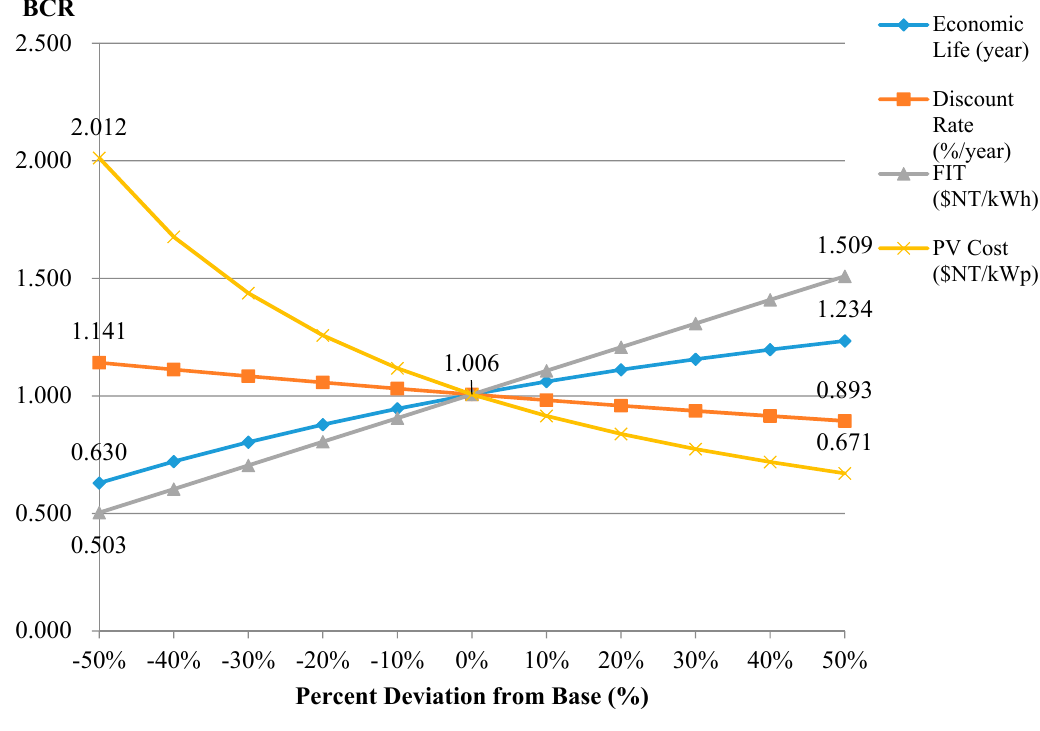
Figure 12. BCR sensitivity graph for four key parameters.